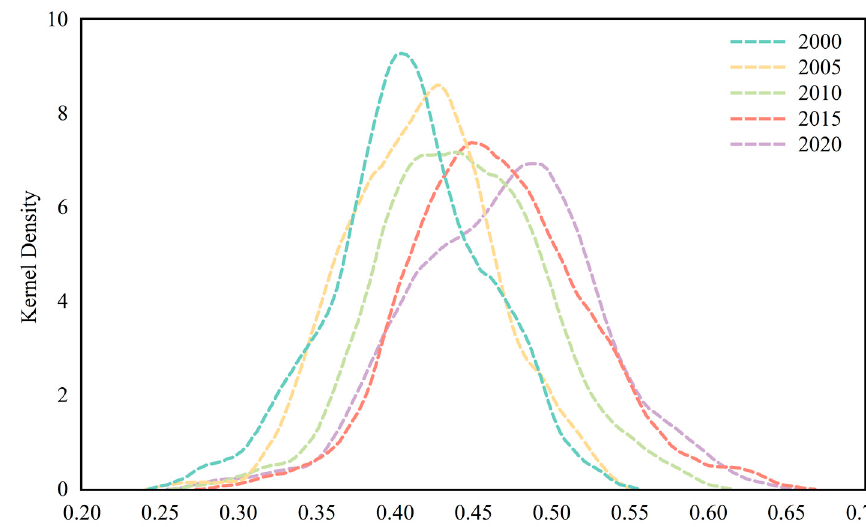
Figure 7. Kernel density curve of the coupling coordination of WLF nexus.